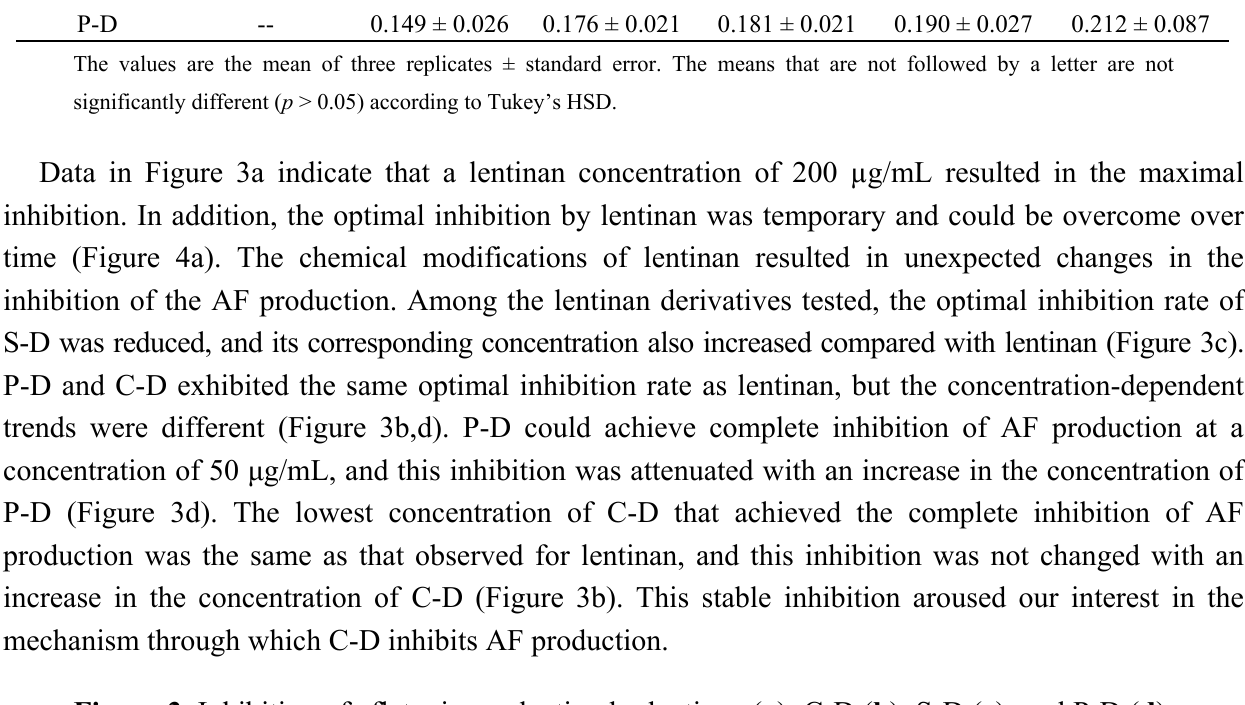
Figure 3. Inhibition of aflatoxin production by lentinan ( a ); C-D ( b ); S-D ( c ); and P-D ( d ). The values are the mean of three replicates ± standard